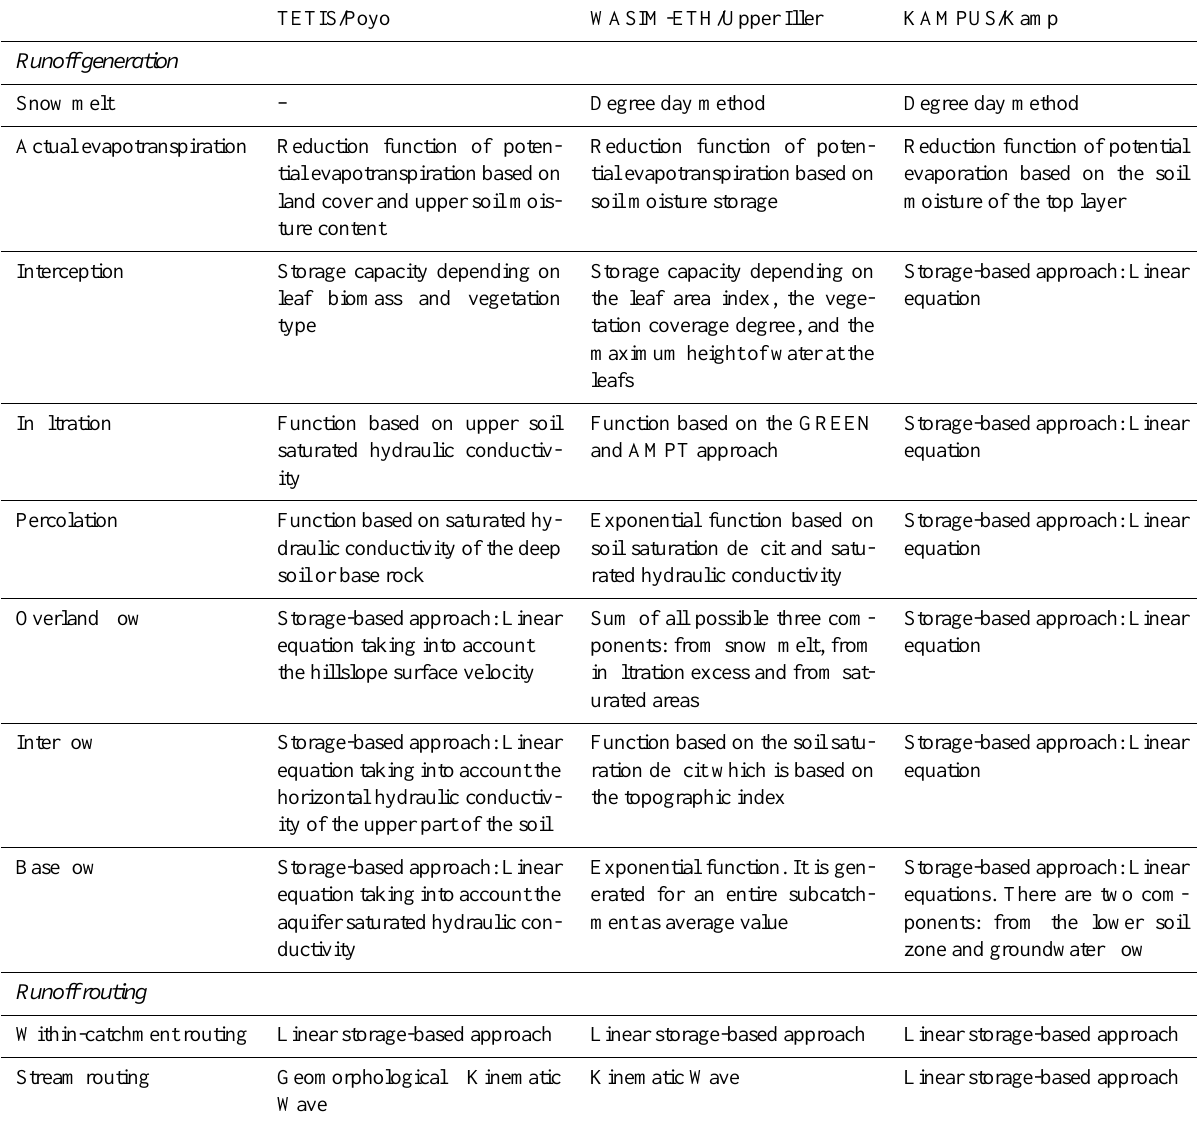
Table 3. Main process descriptions of each catchment